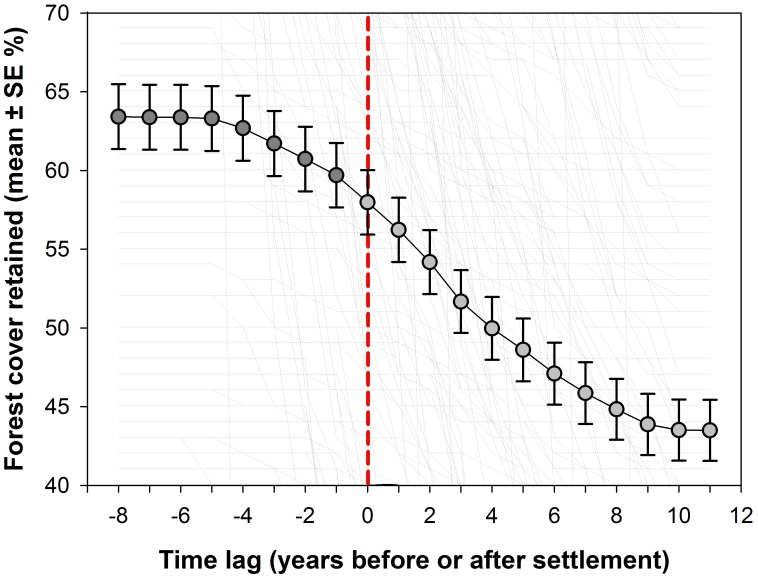
Forest cover retention before and after settlements.Mean annual deforestation within 300 agrarian settlement areas across Brazilian Amazonia, up to 7 years before (yr‒7) and 11 years after (yr+11) their formal establishment. Vertical dashed line indicates the official recognition of any given settlement at year zero (yr0). Forest loss prior to year zero was often associated with agricultural activity by land squatters. Error bars indicate standard errors.